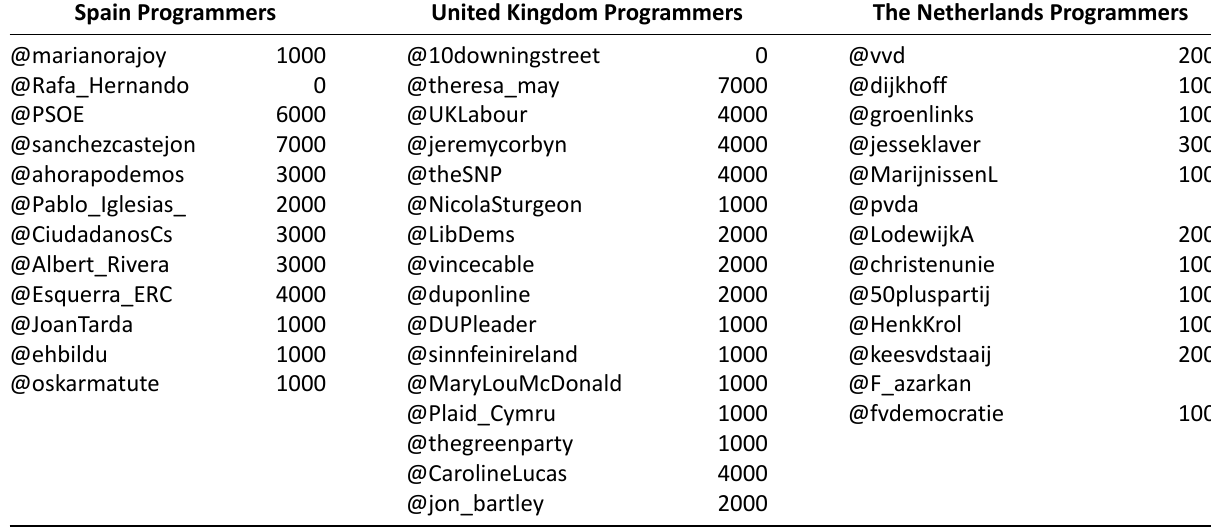
Table 4. Programmers, by